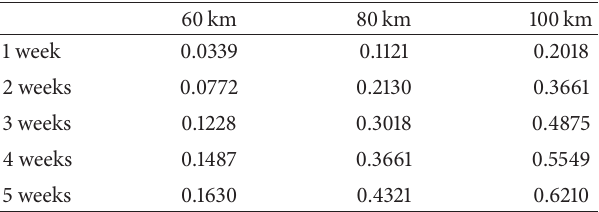
Table 1: AE as precursor from May 9, 2011 to June 16, 2011. Cumula- tive probability 𝐶 + ( r, 𝜏 ) for radius r ranging between 60 and 100 km, and time 𝜏 varying from 1 week to 5